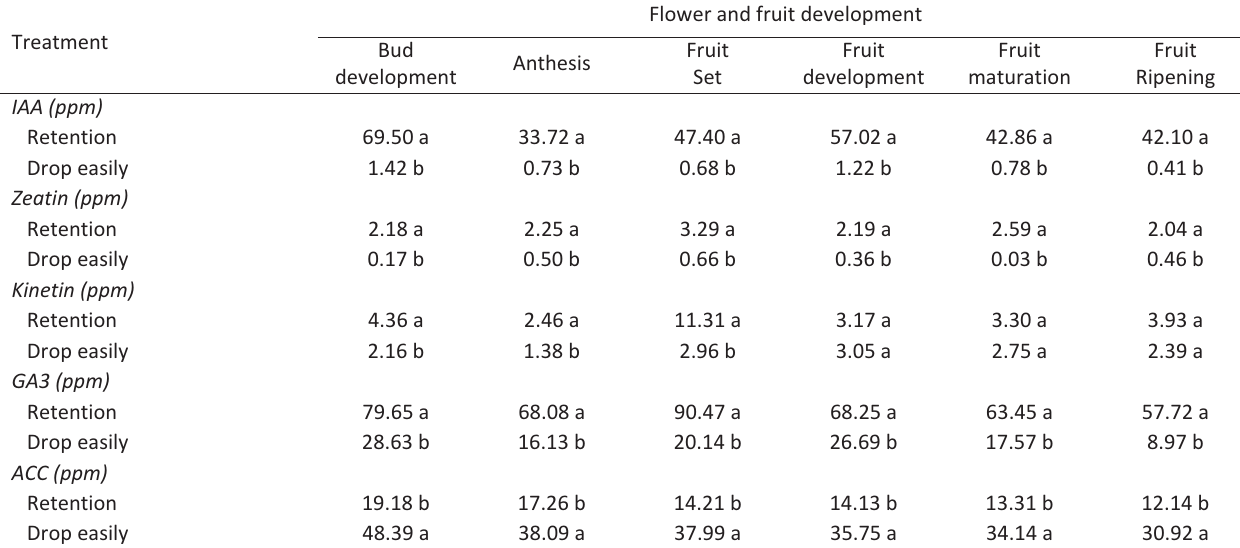
The number followed by the same letter in the same column for each fruit development is not significantly different from the t­test at